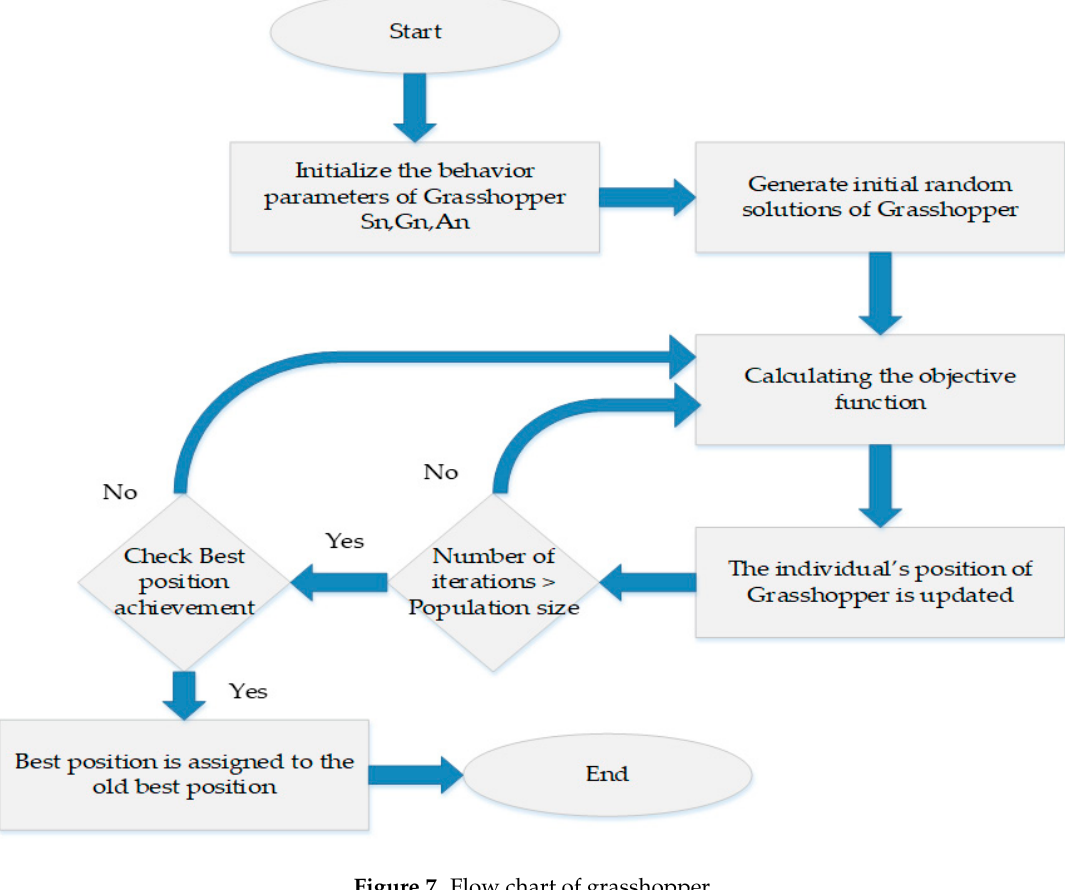
Figure 7. Flow chart of grasshopper.